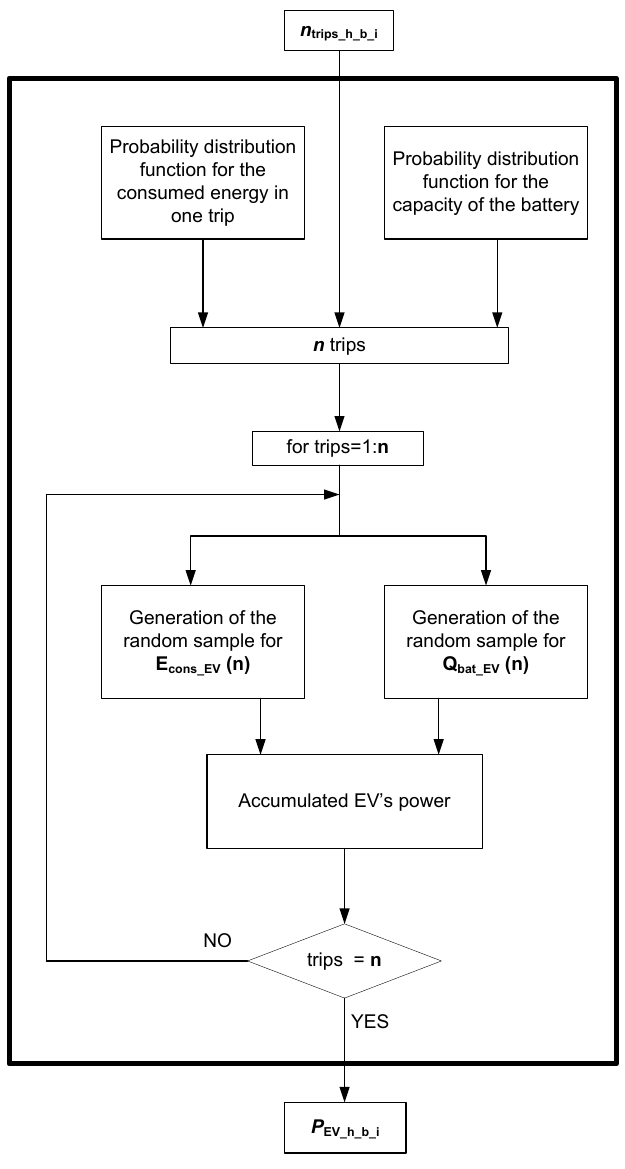
Figure 7. Flow diagram of the consumed power by the EV’s recharge.